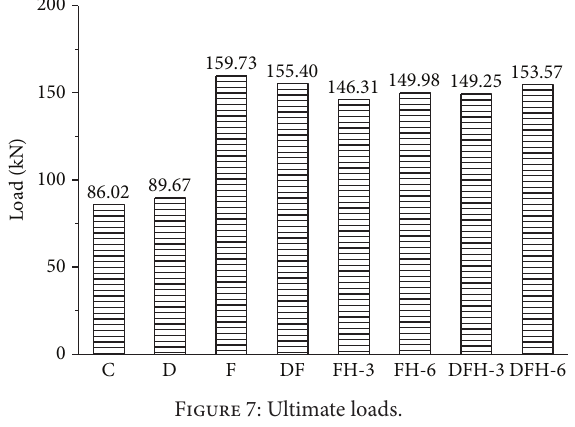
series C, F, DF, and DFH-3 are 0.22 mm, 0.12 mm, 0.19